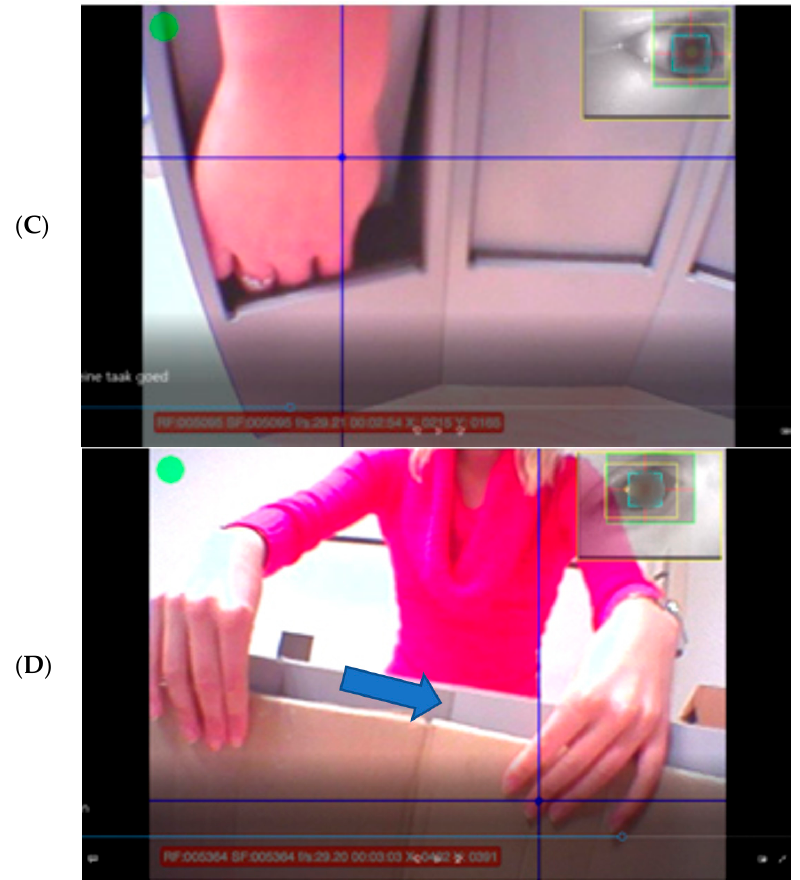
Figure 1. ( A ) Video still of the calibration screen, captured from the infant’s head-camera. The blue cross-hair marks the infant’s looking location. ( B ) A-not-B task with four hiding locations. ( C ) Video still of the A-not-B task set-up during the hiding procedure, from the infant’s head-camera. The blue cross-hair marks the infant’s looking location. ( D ) Video still of the A-not-B task set-up during delay, from the infant’s head-camera. The blue cross-hair marks the infant’s looking location. The blue arrow points to the distinction between the left and right side of the task display, which was used as a reference point during coding.